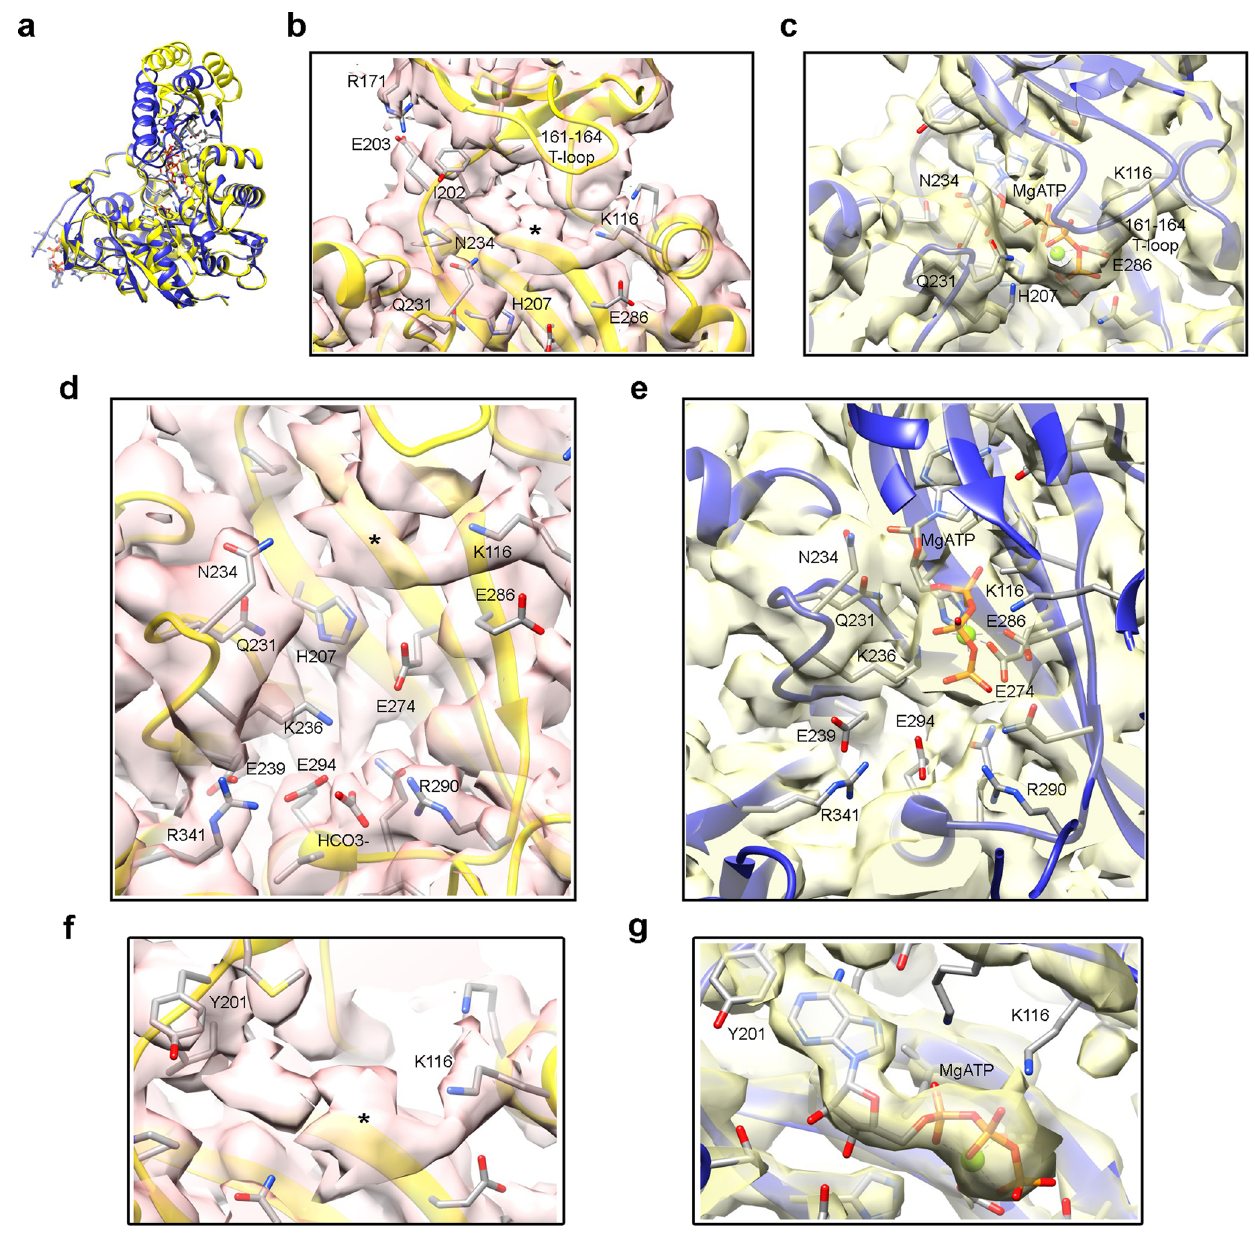
Fig.3|OpenandclosedB-subdomainlid.a AtomicmodelsfortheBC open (yellow) andBC closed (blue)BC-subdomainlidsattheBCsite. b and d BCcatalyticsiteatthe BC open state. c and e BC catalytic center with bound MgATP in the BC closed state. f and g Close-up views of the densities at the nucleotide binding site for BC open ( f )